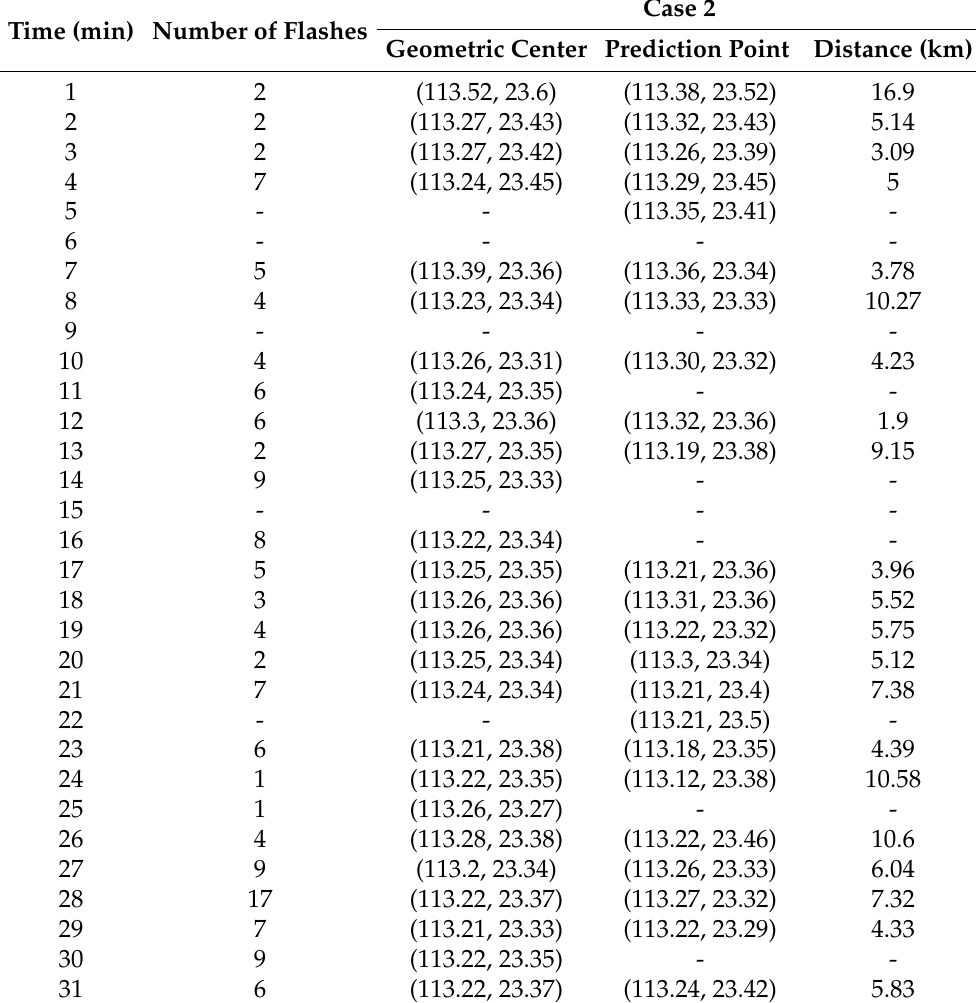
Table 5. Real lightning events and the predicted results given by the system per minute in Case